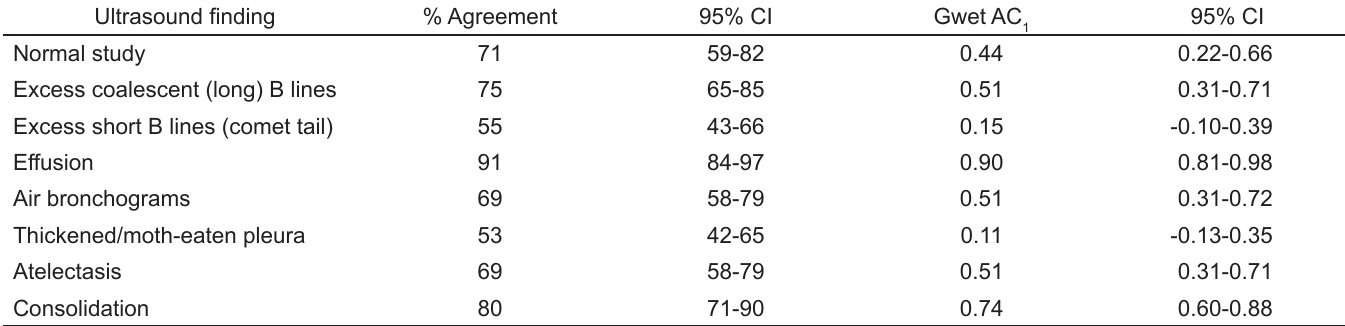
Table 3. Inter-rater agreement between a blinded over-read relying only on saved images and the bedside interpretation of the treating physician. Where the readings differed, the interpretation of the bedside physician ultrasonographer was used.